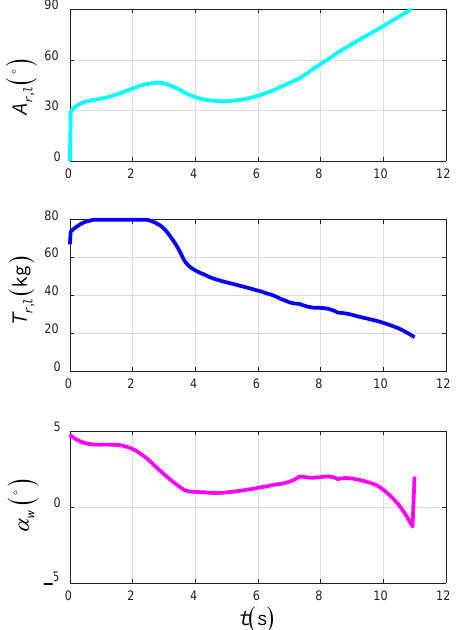
Figure 22. The control variables in TTO.